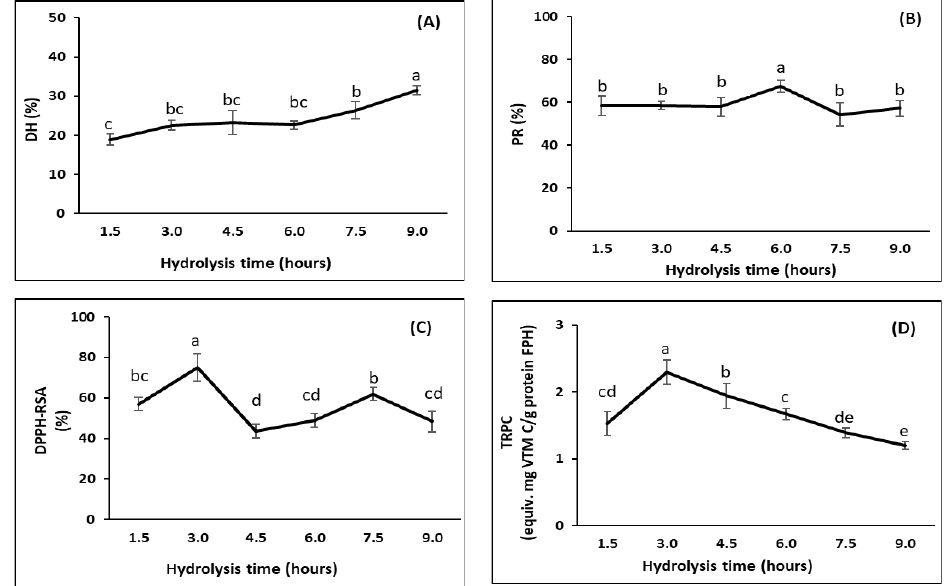
Figure 4. Effect of hydrolysis time (hours) on characteristics of FPHs obtained from the DM-FPI (trial 3), including: ( A ) degree of hydrolysis (DH, %); ( B ) protein recovery (PR, %); ( C ) DPPH radical scavenging activity (DPPH-RSC, %); and ( D ) total reducing power capacity (TRPC, equiv.mg vitamin C/g FPH protein). The hydrolysis reaction was carried out at 50 °C with an enzyme ratio of 3%. Different lowercase letters show significant differences at a significance level of p <